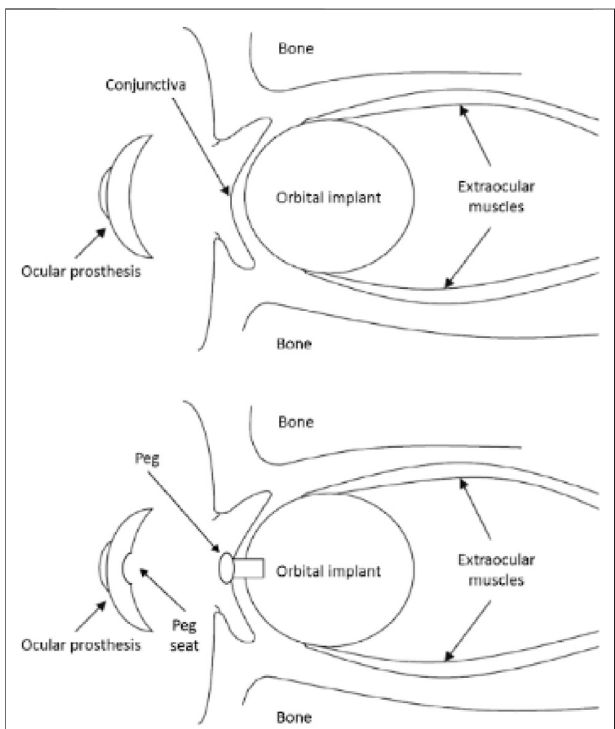
FIGURE 2 | Images of a human orbit following enucleation surgery and spherical implant implantation. Extraocular muscles are sutured directly to the implant in these photos. Reproduced with permission (Baino et al.,